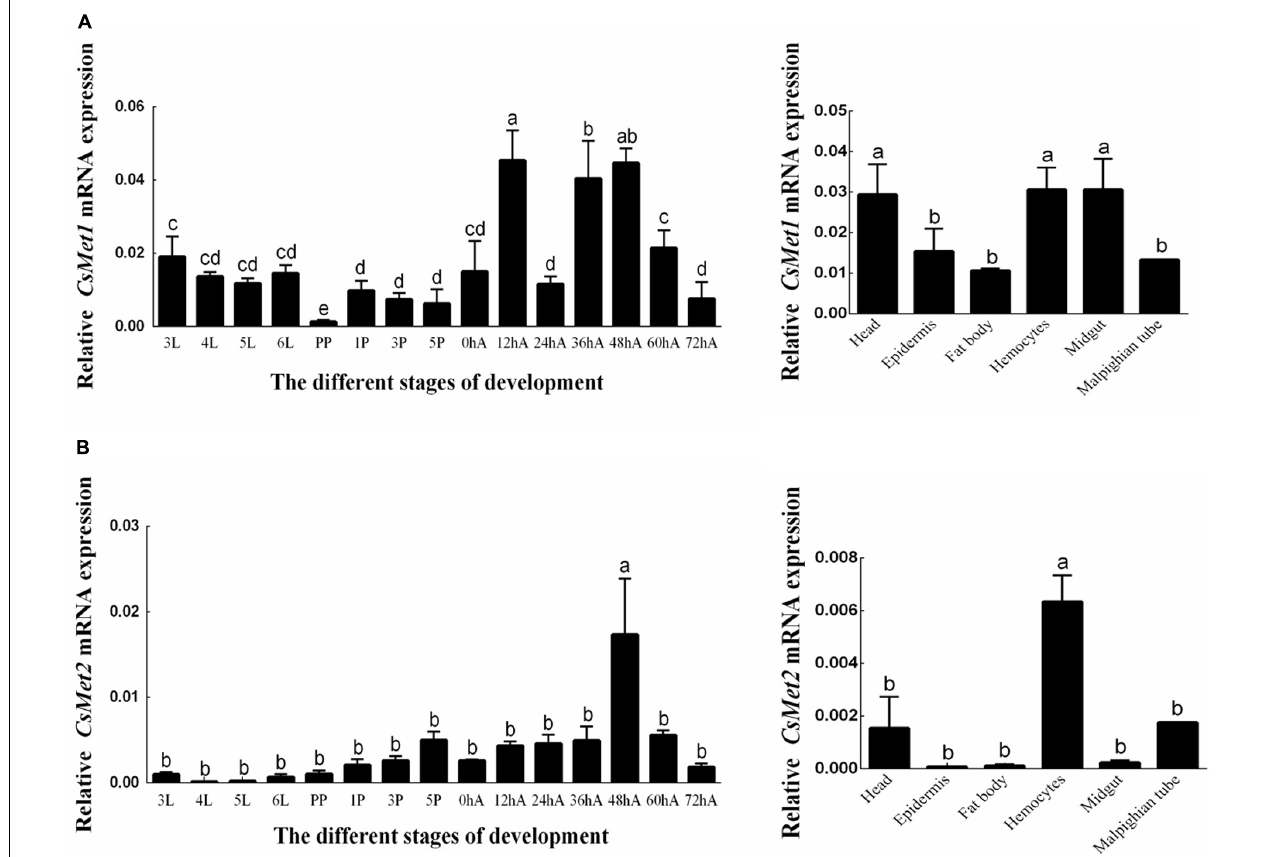
FIGURE 3 | Expression profiles of CsMet1 (A) and CsMet2 (B) in different developmental stages and various tissues from 5 th instar larva. 3L: 3 3rd instar larvae; 4L: 4 th instar larvae; 5L: 5 th instar larvae; 6L: 6 th instar larvae; PP: prepupae; 1P: 1-day-old pupae; 3P: 3-day-old pupae; 5P: 5-day-old pupae; 0hA: newly emerged